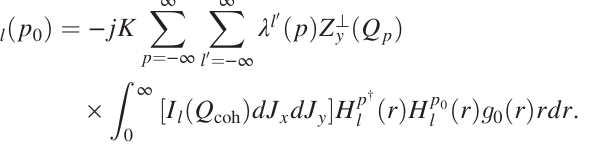
at points where modes max